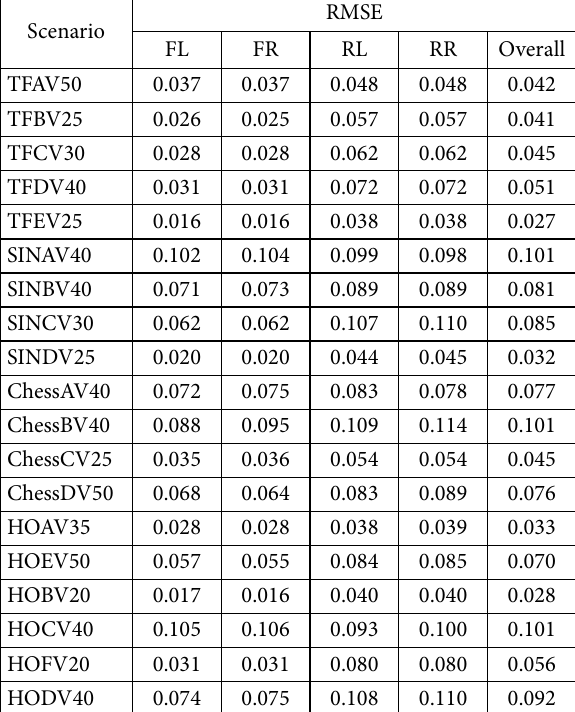
Table 3. RMSE achieved in testing scenarios for each wheel